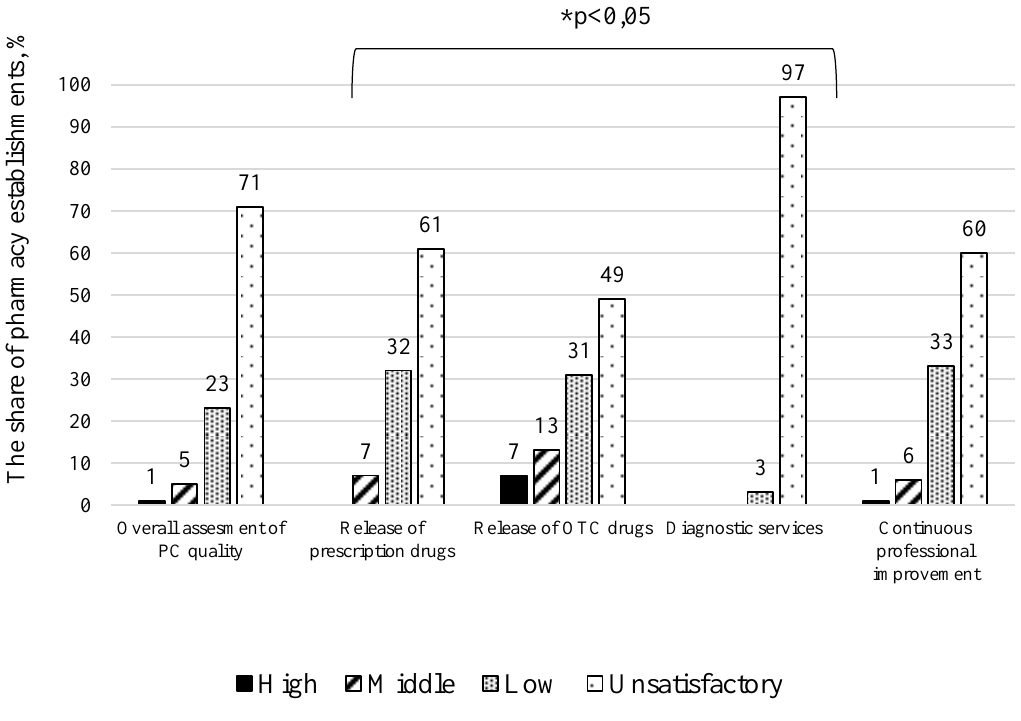
Fig. 3. Analysis of the quality of pharmaceutical care in pharmacy establishments of Ukraine (* p-level=0.000 <0.05,  2